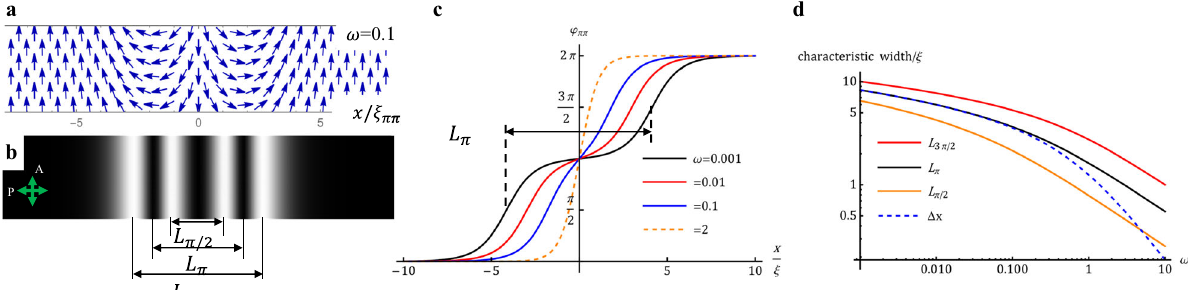
Fig. 6 Equilibrium ππ soliton-soliton pairs described by Eq. (7). a In-plane polarization fi eld for ω = 0.1. b The corresponding texture observed between crossed polarizers with the intensity of transmitted light calculated with Eq.(8). c Polarization pro fi le φ ππ ( x ) for different surface anchoring anisotropies ω ; the separation L π between two extinction bands at φ ππ = π /2 and φ ππ = 3 π /2 is shown for the pro fi le with ω = 0.001. d Characteristic widths of the ππ soliton-soliton pairs de fi ned in ( b ) vs. ω ; note that Δ x ≅ L π for ω < 0.1, but Δ x < L π for ω